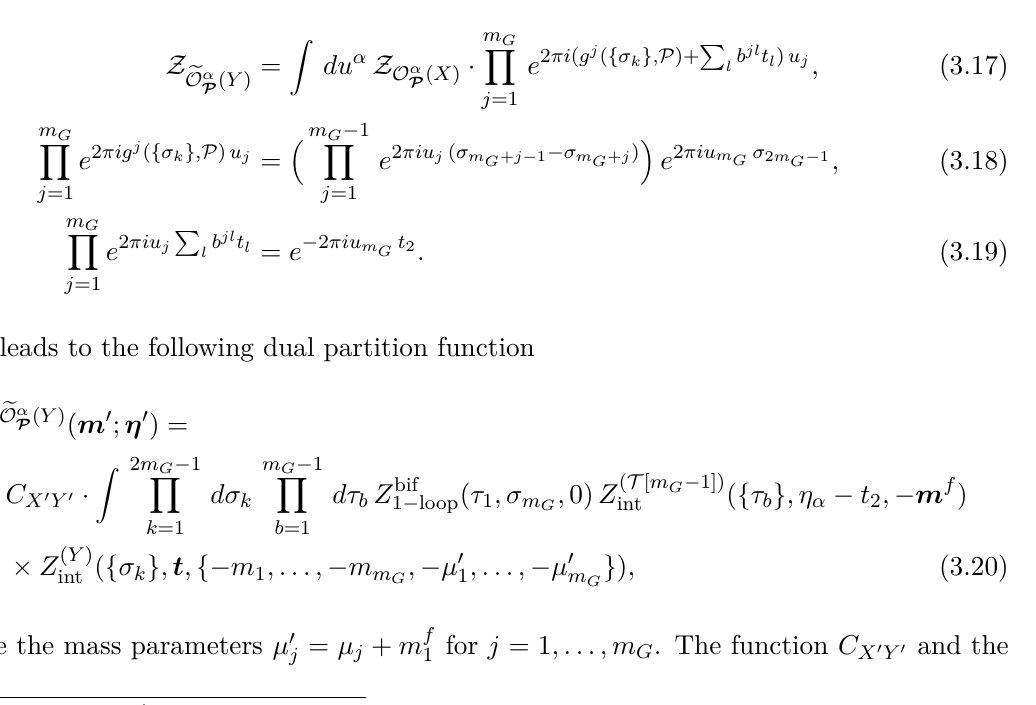
gauge node of Y . m G